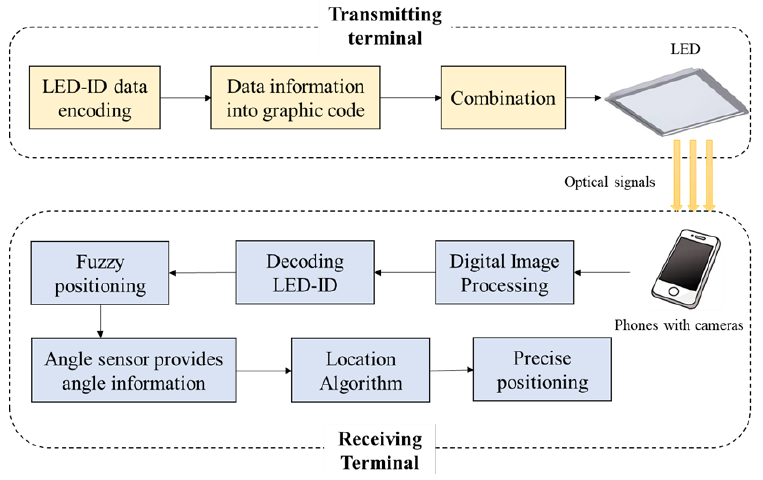
Figure 3. The LP-VLP system. The flat panel light positioning technology in this paper uses barcodes to represent location information. According to the design and practical needs of the positioning system in this paper, the barcode frosted film has the following two